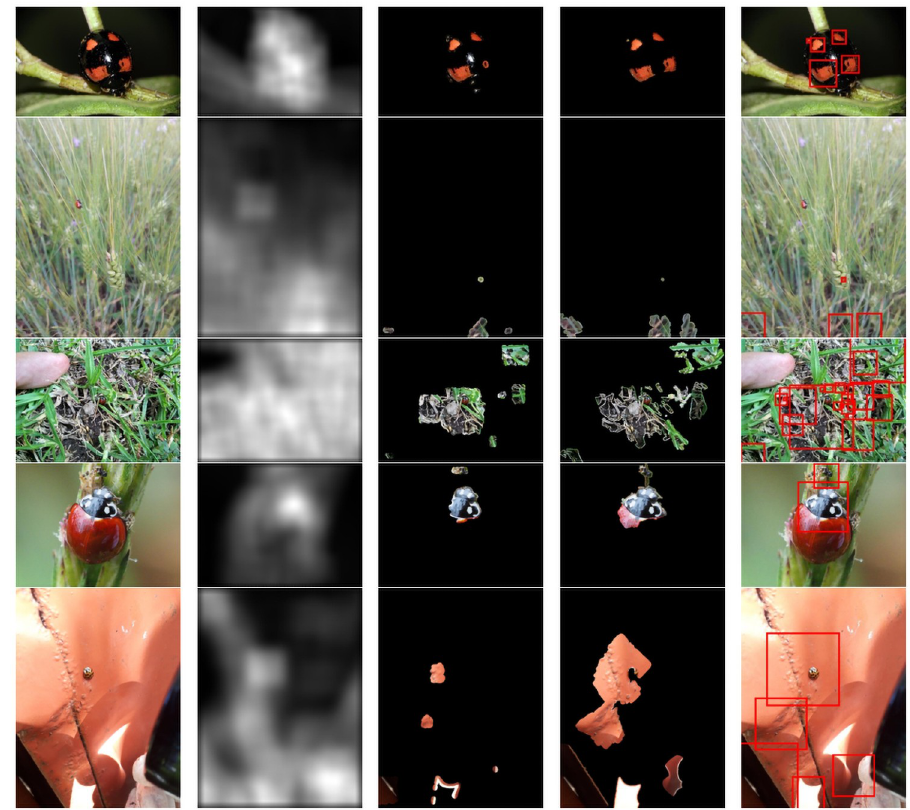
Fig 7. Unsuccessful performance examples of the image processing module (first stage of the proposed detector) in different environments. From left to right, original image, saliency map, SLIC superpixels segmentation, Chan- Vese active contour, and final bounding boxes